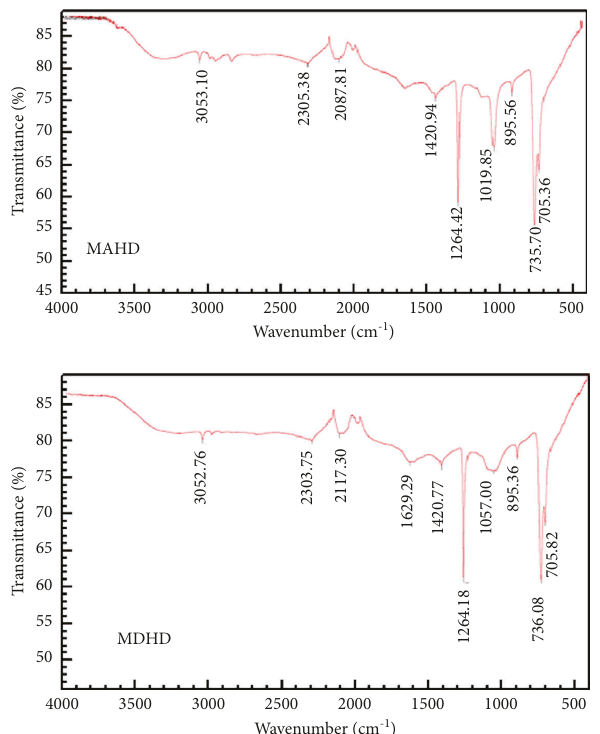
Figure 3: FTIR spectrum of essential oil for hibiscus flower through MAHD and HD.